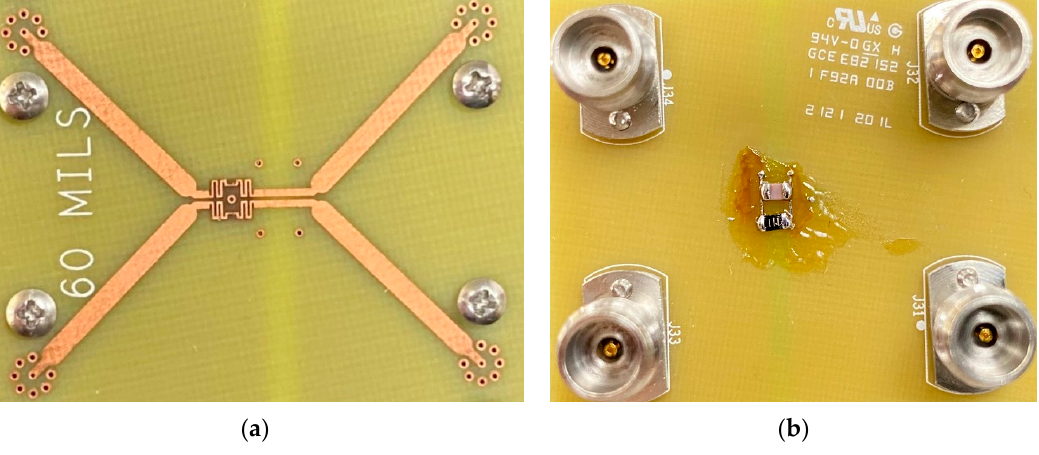
Figure 10. ( a ) Top and ( b ) bottom view of the practical circuit.